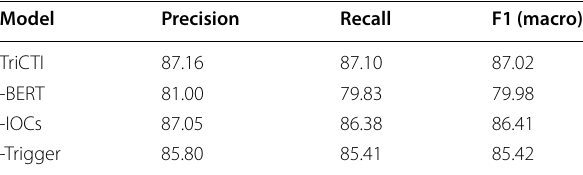
The experimental results (average value over 3 repeated runs) are carried out on augmentation data